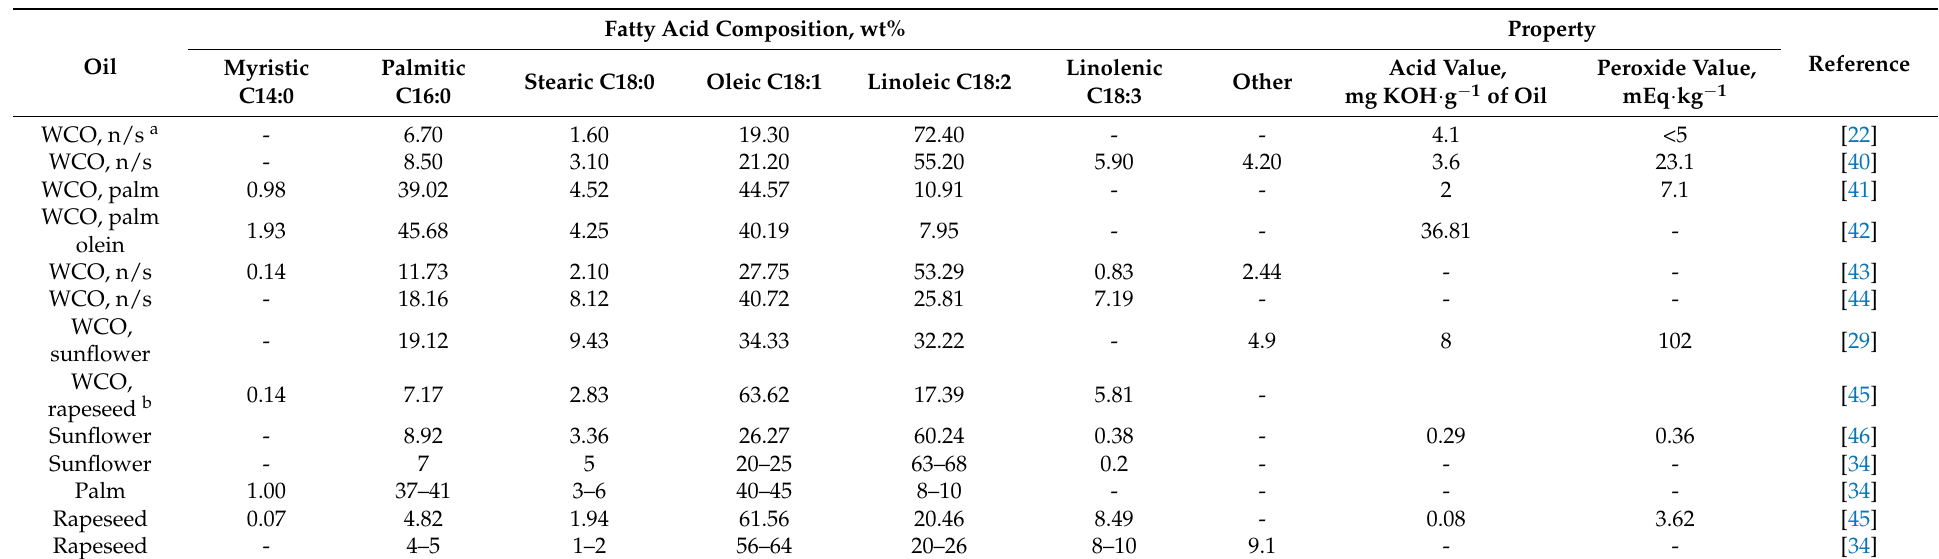
Table 1. Composition and properties of the WCO and raw cooking